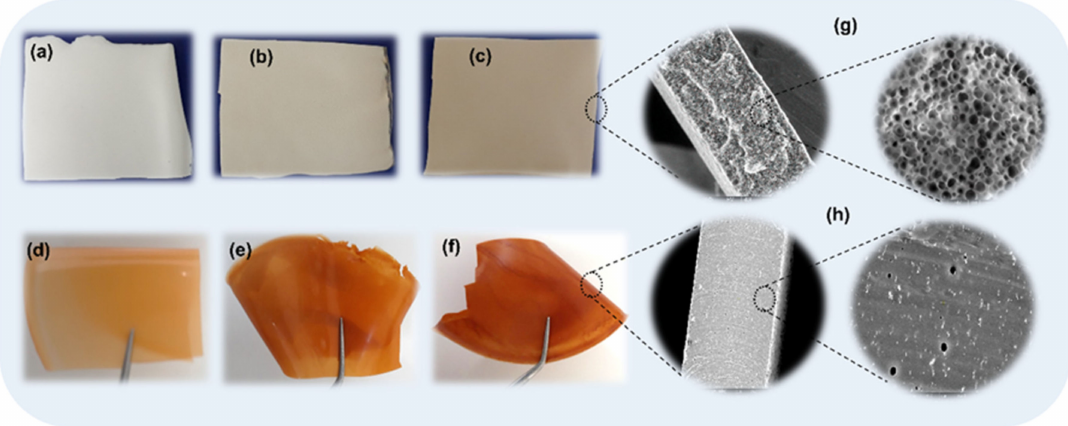
Figure 5. Illustration of composite membranes prepared by wet solution casting method (Pw), with ( a ) 0.1%, ( b ) 0.5%, and ( c ) 1% IONPs content, and in dry solution casting method (Pd) with ( d ) 0.1%, ( e ) 0.5%, and ( f ) 1% IONPs content. Cross-sectional visualization of membranes by SEM (scale bare 200 µ m with magnification 100 × and 20 µ m with magnification 5000 × , respectively) corresponding to the 1% IONPs content, prepared by wet ( g ) and dry ( h ) solution casting